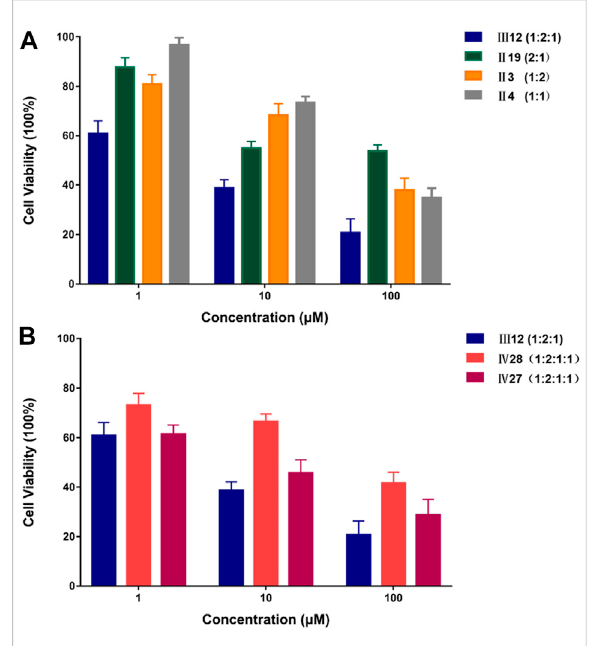
FIGURE 5 The comparison of anti-cancer effect on MCF-7 cell line between III12 and related combinations. (A) . The comparison of anti-cancer effect on MCF-7 cells between III12 and related pairwisecombinationsthatwereextractedfromIII12. (B) .The comparison of anti-cancer effect on MCF-7 cells between III12 and four-drug combinations which included the entire III12